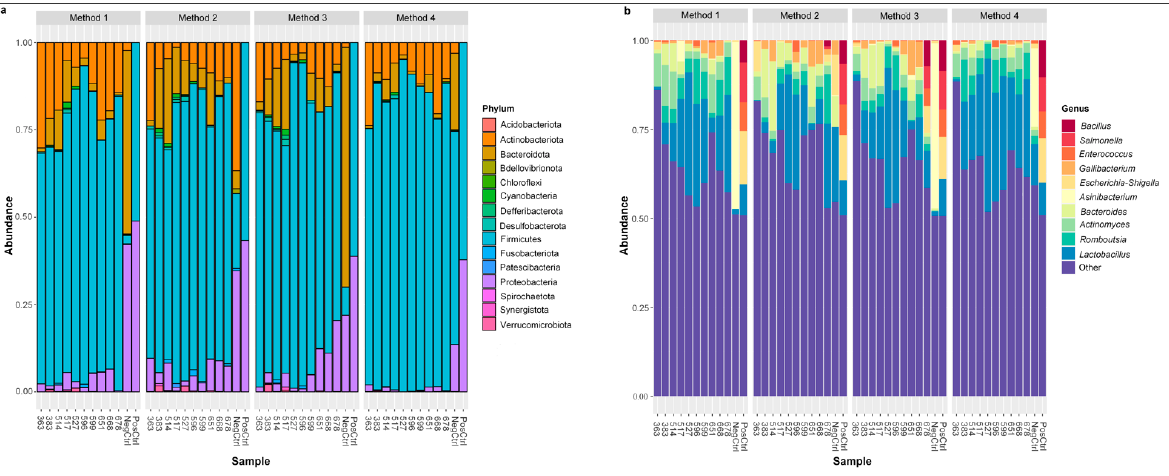
Figure 4. Distribution of the most abundant phyla and genera is similar across each DNA extraction method. Relative abundance of most prevalent phyla ( a ) and 10 most abundant genera ( b ) detected in cloacal samples among each DNA extraction method, where “Other” makes up the total relative abundance of other common genera.